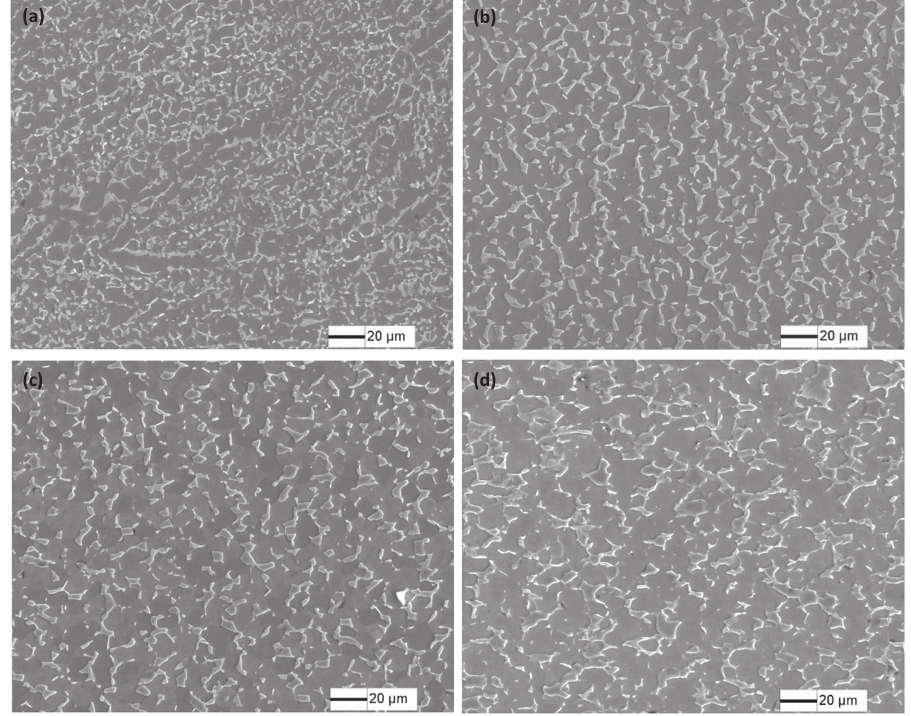
Figure 11: Microstructures at various positions of tensile specimen (a) a part (b) b part (c) c part (d) d